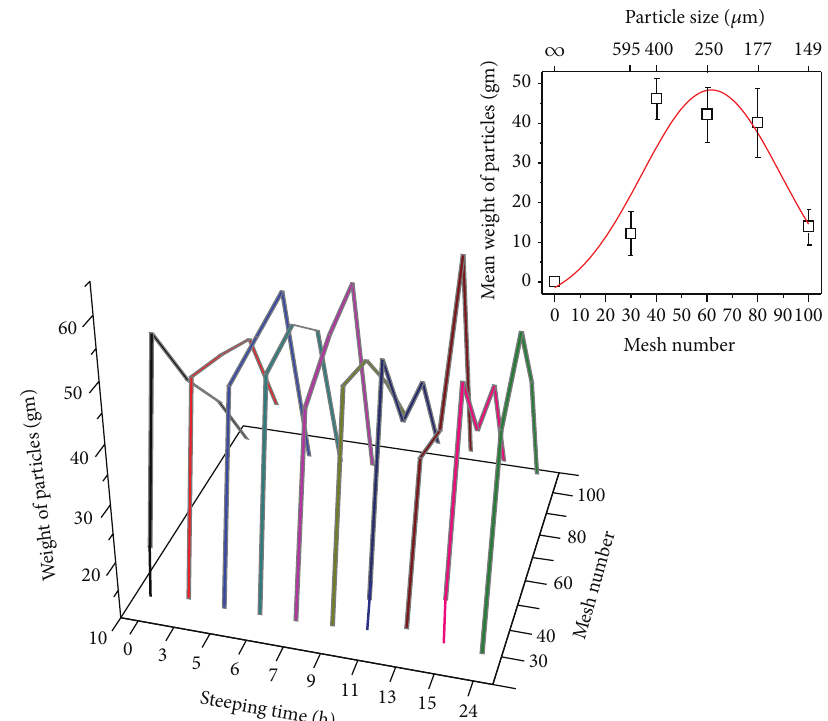
Figure 1: The weight of PSD (W-PSD) as a function of the mesh numbers for all the steeping times (ST) values studied. The inset illustrates the mean W-PSD value versus the mesh number averaged on the five mesh screens selected for the analysis. The red line is a fitting by using a Gaussian